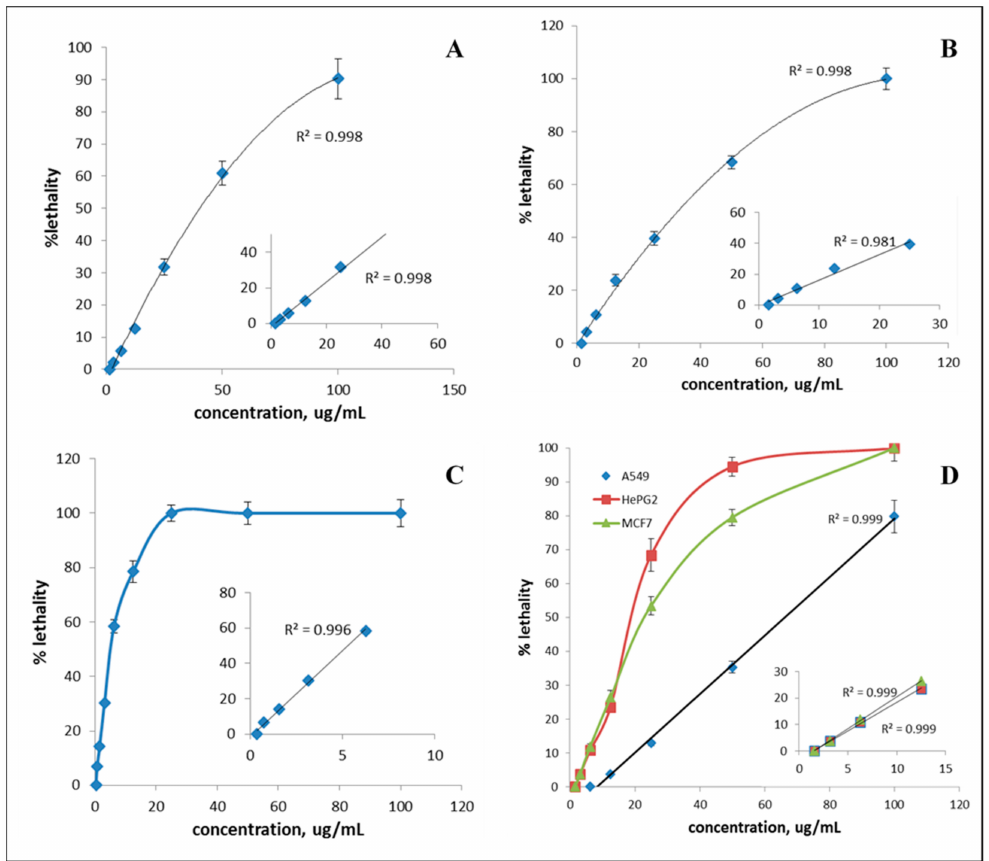
Figure 4. Evolution of % lethality with concentration for ( A ) S1 fraction on HCT116 colon cancer cells, ( B ) F8 fraction on MCF7 breast cancer cells, ( C ) F4 fraction on HePG2 human hepatocellular carcinoma cells, and ( D ) F5 fraction on A549, HePG2, and MCF7 cells. The linear parts of the curves are shown in the figure